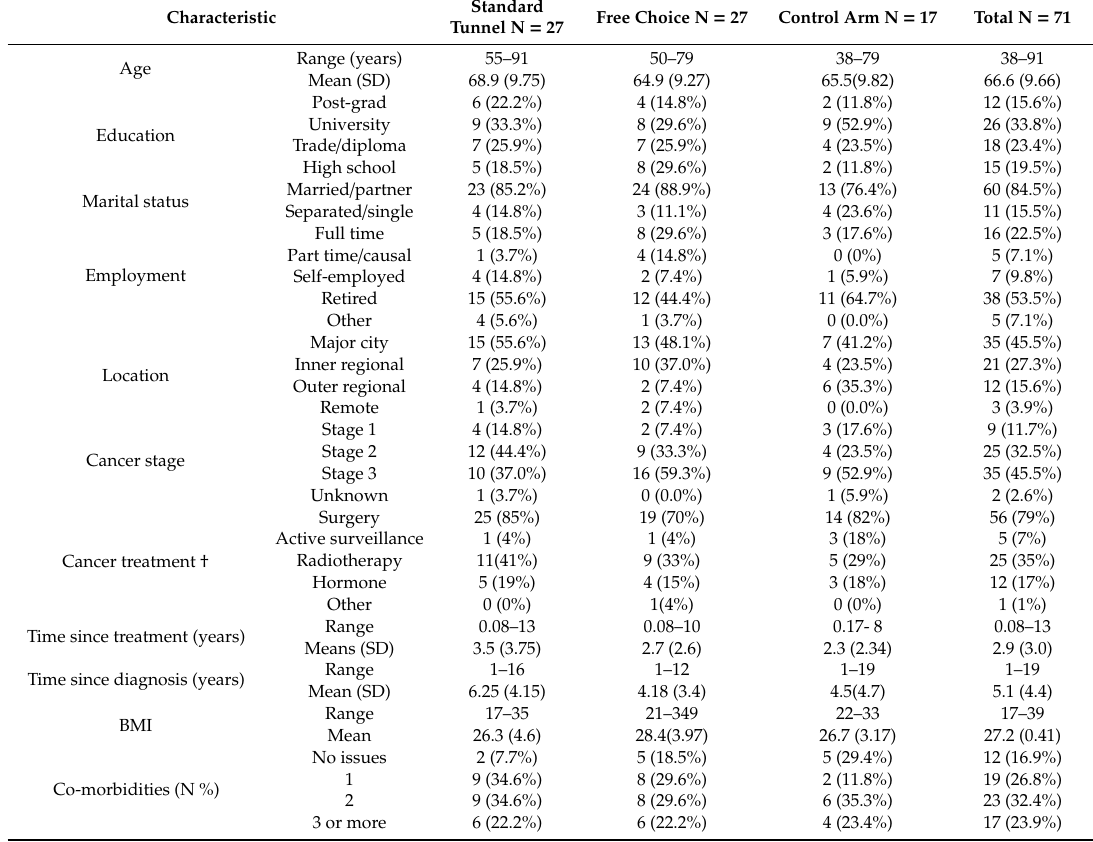
Table 1. Participant characteristics (complete baseline data N = 71).